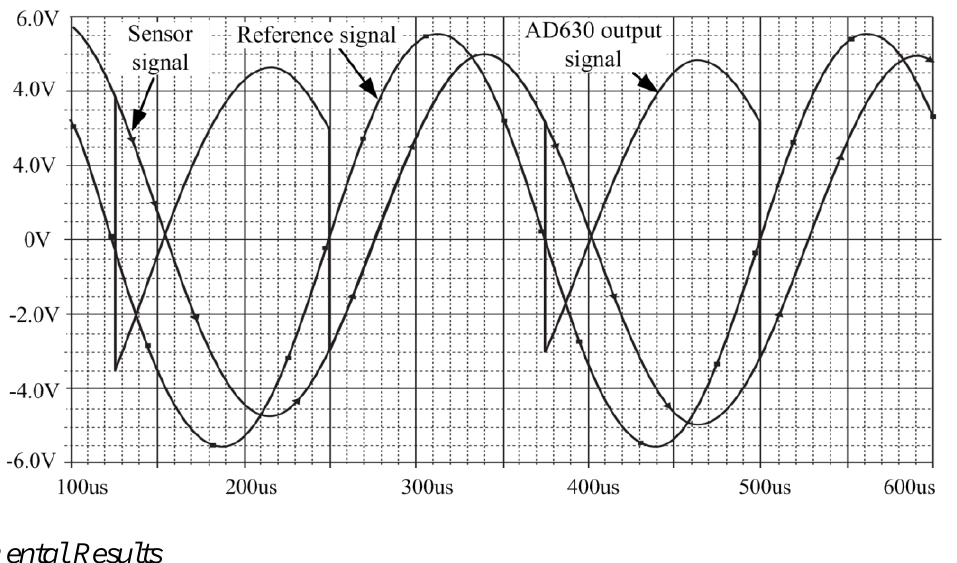
Figure 18. Pspice simulation result.